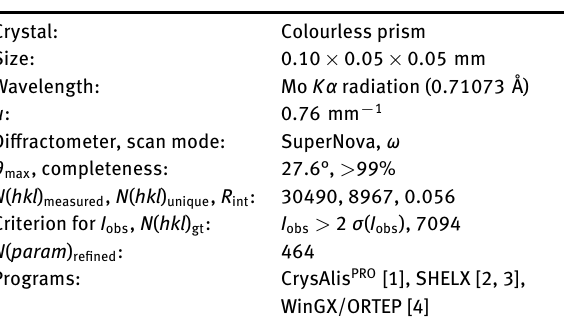
Table 1: Data collection and handling.